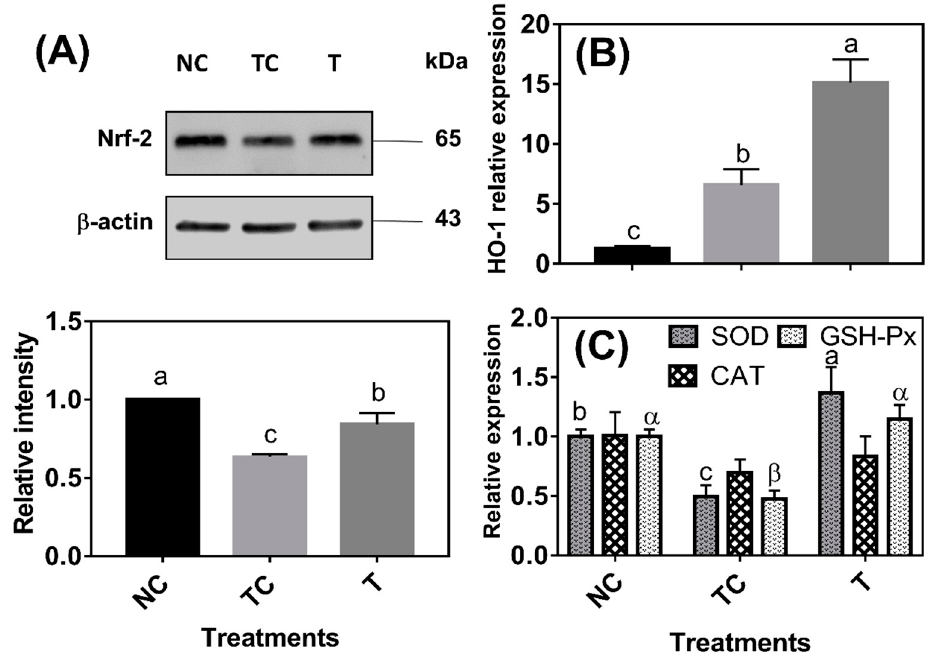
Figure 3. The e ff ect of red-osier dogwood extracts (RDE) on the Nrf-2 protein level ( A ), HO-1 mRNA expression ( B ), and antioxidative enzymes mRNA levels ( C ) of Caco-2 cells after H 2 O 2 treatment. NC indicates negative control: cells were cultured with a medium without H 2 O 2 and RDE for 27 h (3 h + 24 h). TC indicates treatment control: cells were cultured with a medium containing 1 mM of H 2 O 2 for 3 h, and then treated with a normal medium for 24 h. T indicates RDE treatment: cells were cultured with medium containing 1 mM of H 2 O 2 for 3 h, and then treated with a medium containing100 µg/mL of RDE for 24 h. The data were presented as mean ± SD, n = 4. Different lower case letters and Greek letters indicate a significant difference at P < 0.05. Nrf-2: nuclear factor erythroid 2-related factor 2,